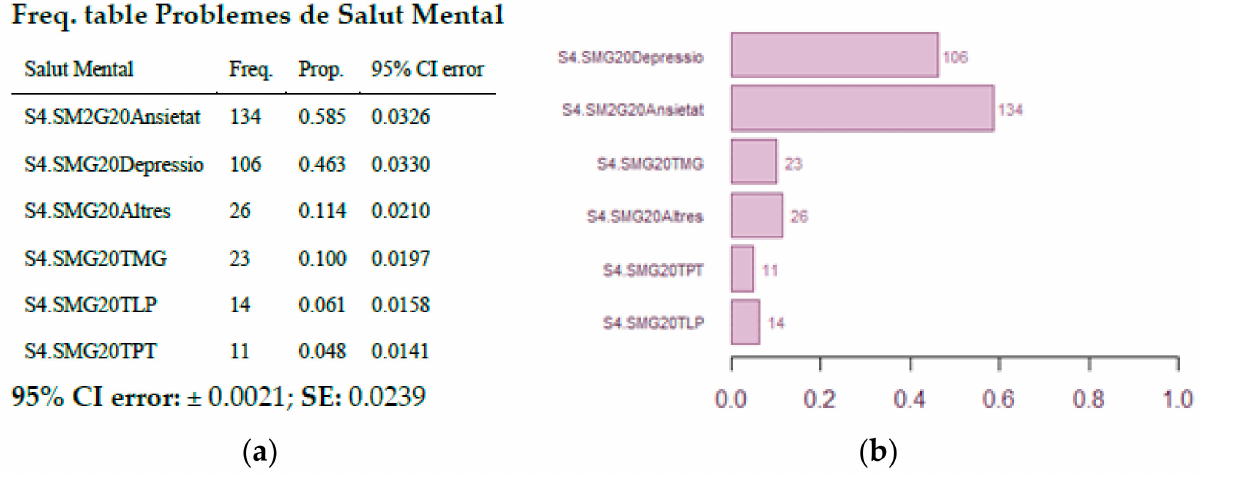
Figure 44. ( a ) Frequency table of Mental disorders. ( b ) Marginal bar plot of Mental Disorders.